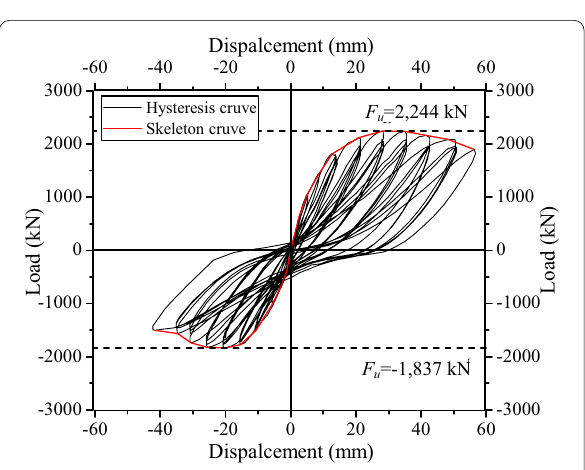
Fig. 18 Hysteresis and skeleton curve of